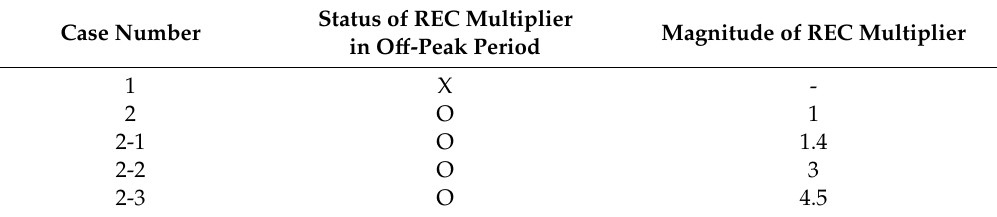
Table 4. Summary of the case